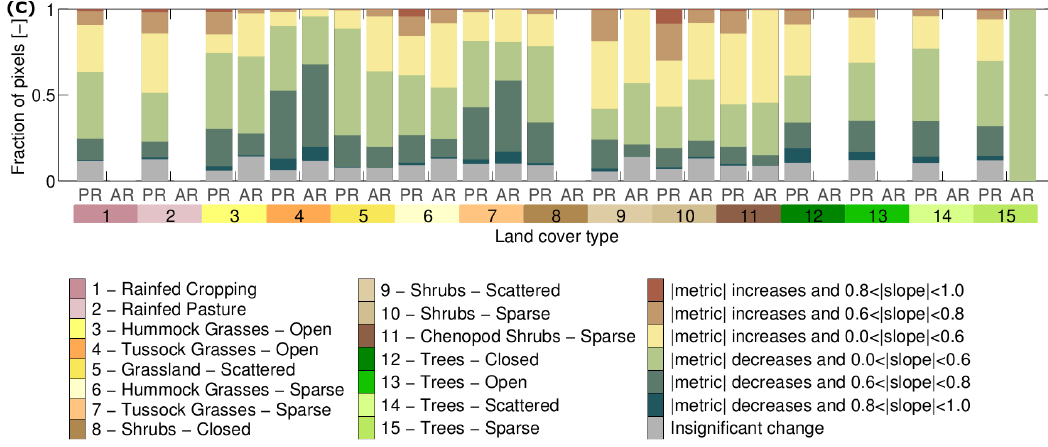
Figure 7. Overview of the temporal slope of the stability metrics (( A ) standard deviation (SD), ( B ) auto-correlation (AC) and ( C ) cross-correlation between the NDVI and climate time series (CS)) for each land cover type (bar color) and disturbance regime (PR: productive lands; AR: arid lands/rangelands). A red-orange color indicates that the stability decreased (i.e., the absolute value of the metric increased), while a blue-green color denotes an increase in stability (i.e., the absolute value of the metric decreased). Red and blue colors suggest a consistent change, while for yellow-green colors, the change is less consistent. The pixels for which the stability metric derived over the whole time series length was not significant were not taken into account, and land cover types having 100 pixels or less were discarded.